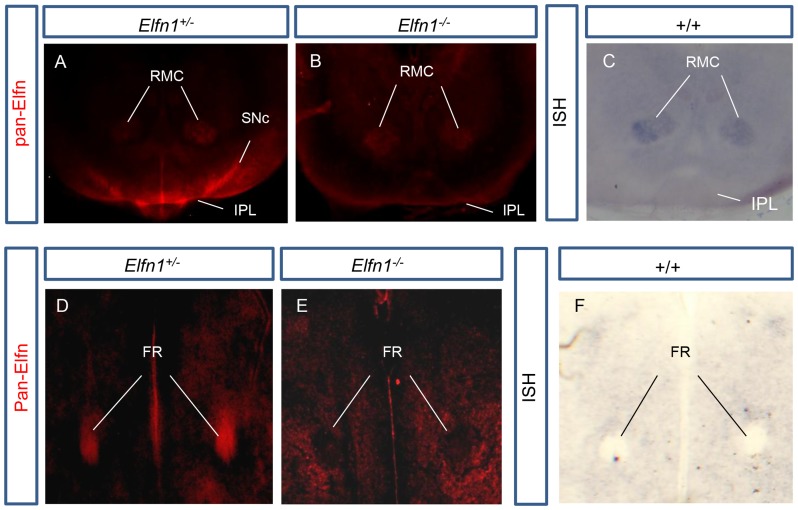
ELFN1 localises to axons of the lateral IPN, the substantia nigra pars compacta and the fasciculus retroflexus.Pan-ELFN positive staining is visible in the IPL and SNc of the Elfn1+/− (A) but not in Elfn1−/− brain (B). In situ hybridisation with an Elfn1 probe in this region shows that Elfn1 is not expressed by cells in the SNc or the IPL at P0 (C). (D) In the Elfn1+/− brain at P0, the pan-ELFN antibody displays strong axonal-like staining in the core of the fasciculus retroflexus (FR). (E) pan-ELFN antibody staining is absent from the FR in the Elfn1−/− brain. (F) Elfn1 in situ hybridisation shows that Elfn1 is not expressed by cells in the FR. FR, fasciculus retroflexus; IPL, lateral subnucleus of the interpeducular nucleus; RMC, Red nucleus magnocellular part; SNc, substantia nigra pars compacta.